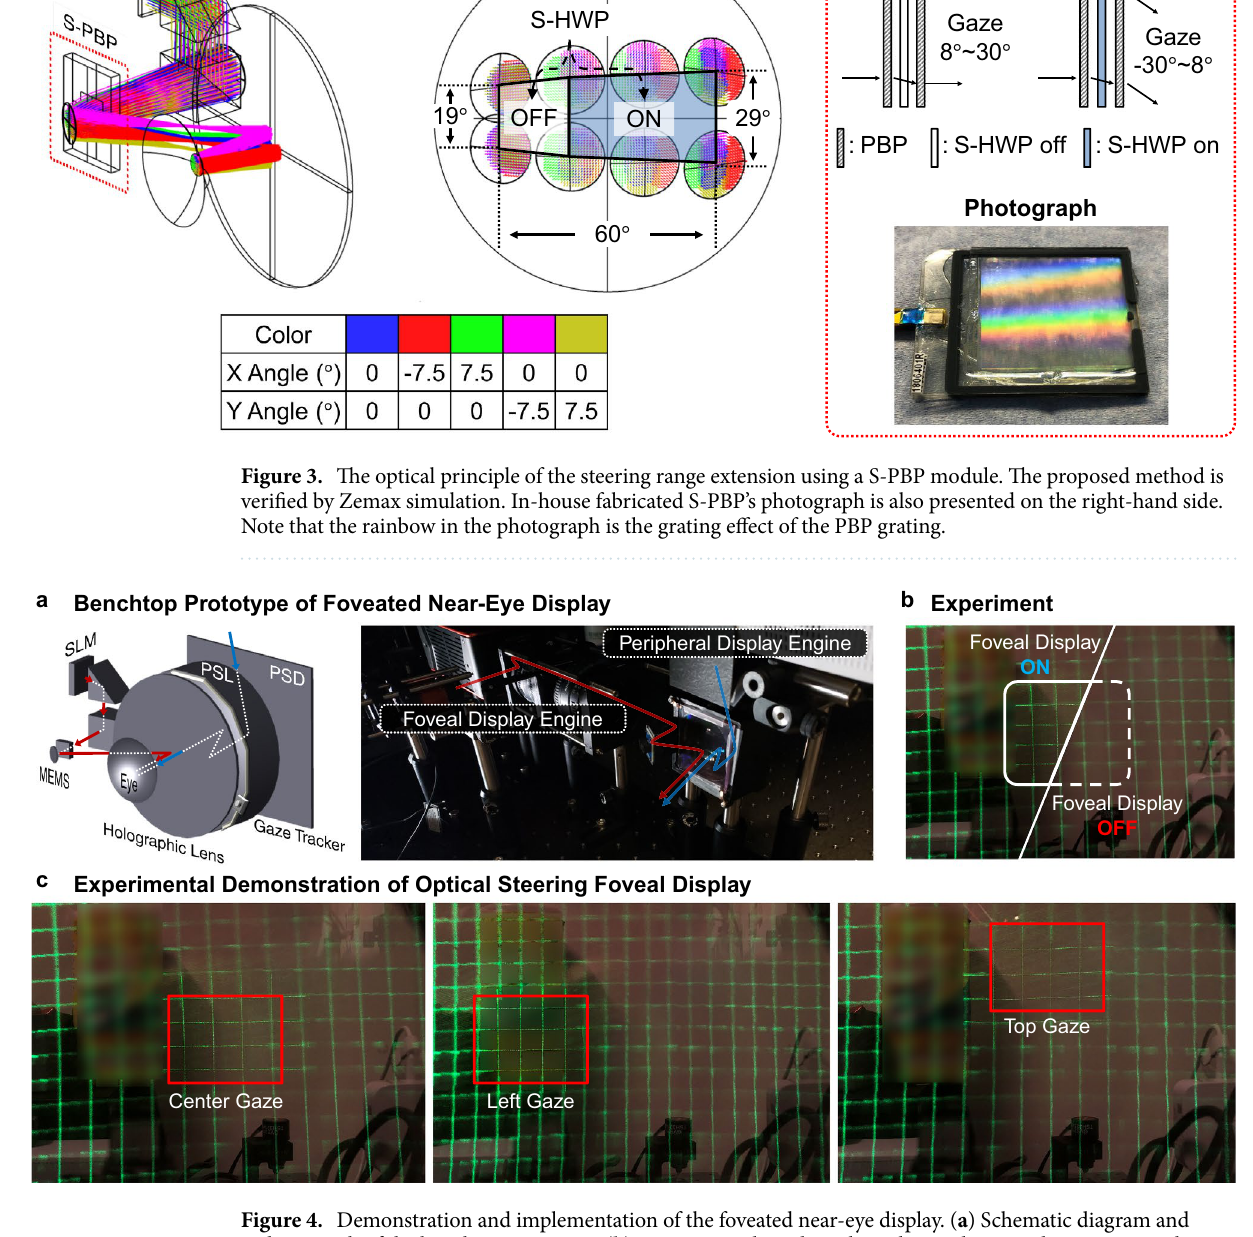
Figure 4. Demonstration and implementation of the foveated near-eye display. ( a ) Schematic diagram and a photograph of the benchtop prototype. ( b ) Experimental result to show the resolution enhancement in the foveal region. We compare two experimental results where the foveal display is on or off. ( c ) Demonstration of optical steering the viewing window of the foveal display using the MEMS mirror. Optical steering results for horizontal and vertical direction are presented. Note that the resolution enhancement by the foveal display is more significant than the demonstration in these photographs. The photographs are captured by a mobile phone camera where the maximum angle resolution is less than the resolution limit of the foveal display (30 cpd). Due to copy right permission, we blurred portion of the